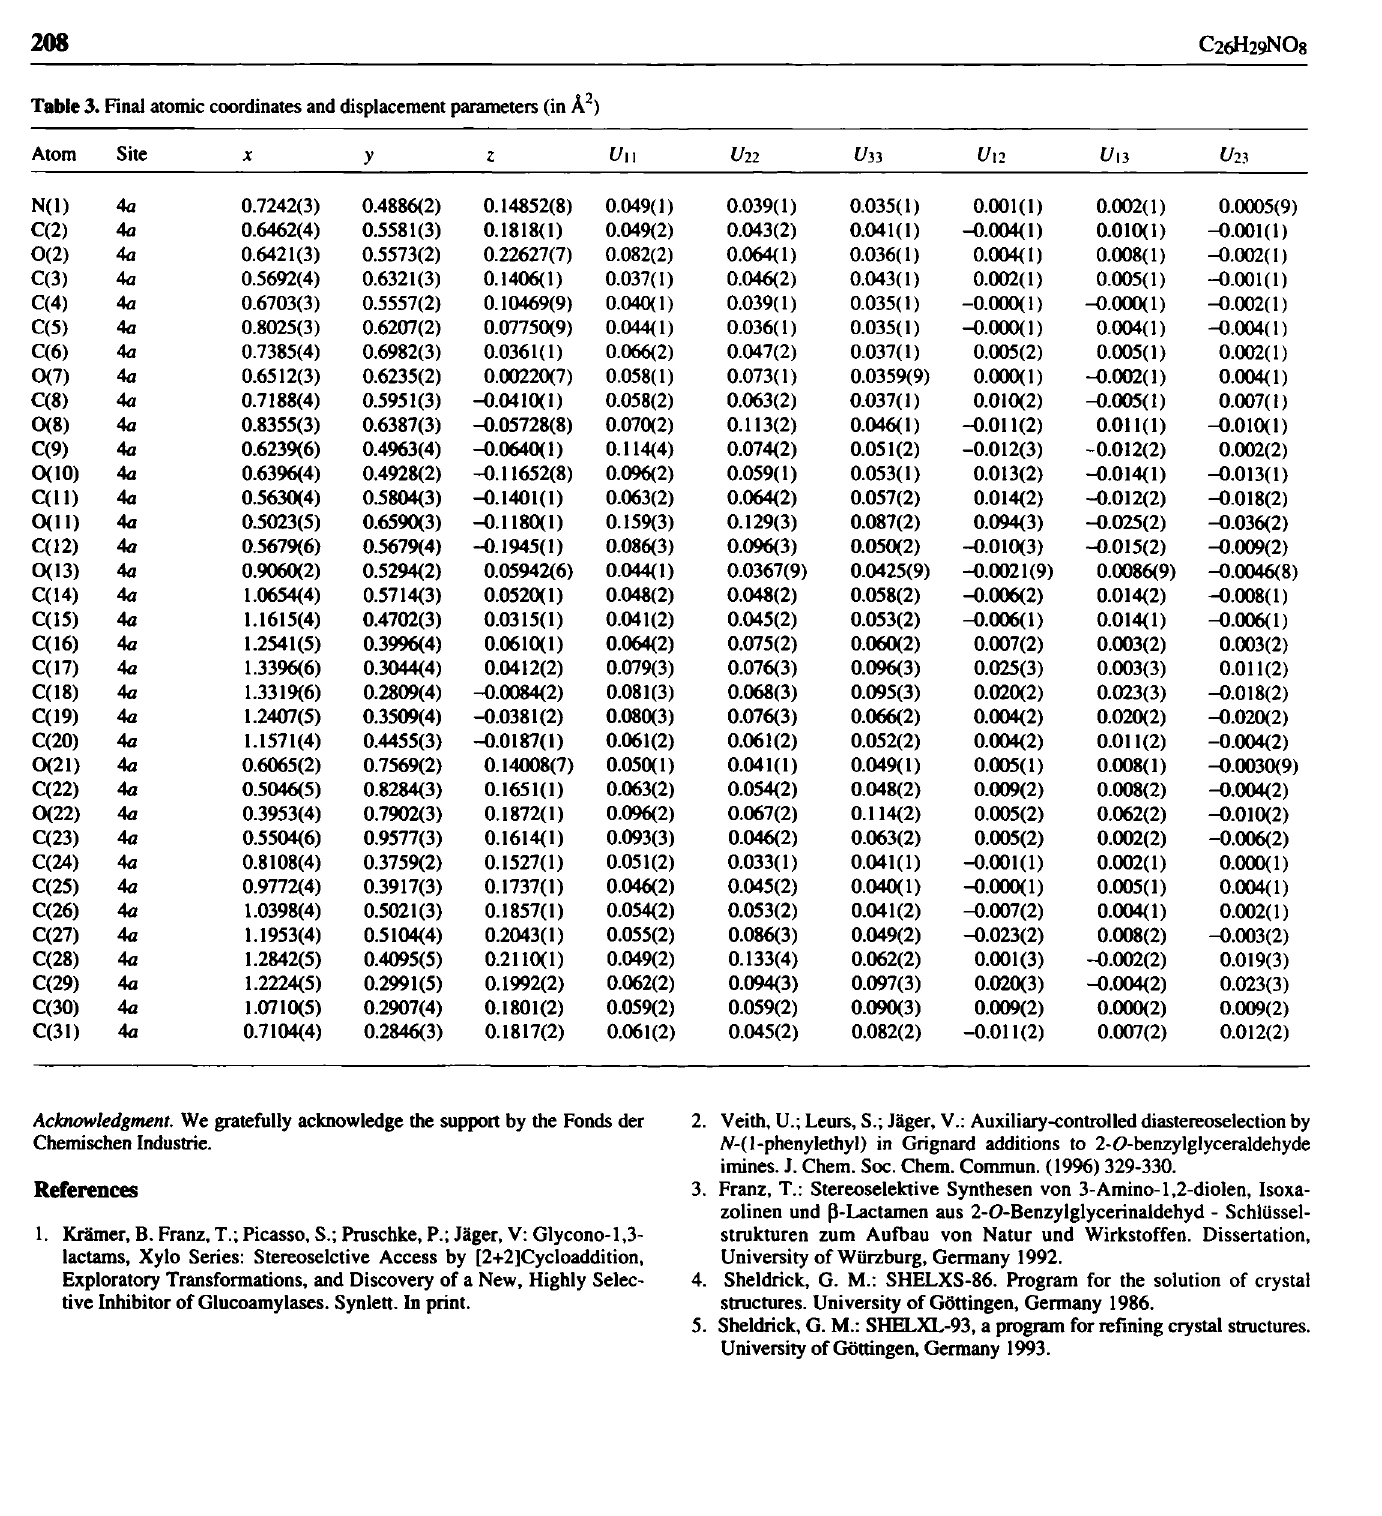
Table 3. Final atomic coordinates and displacement parameters (in A 2